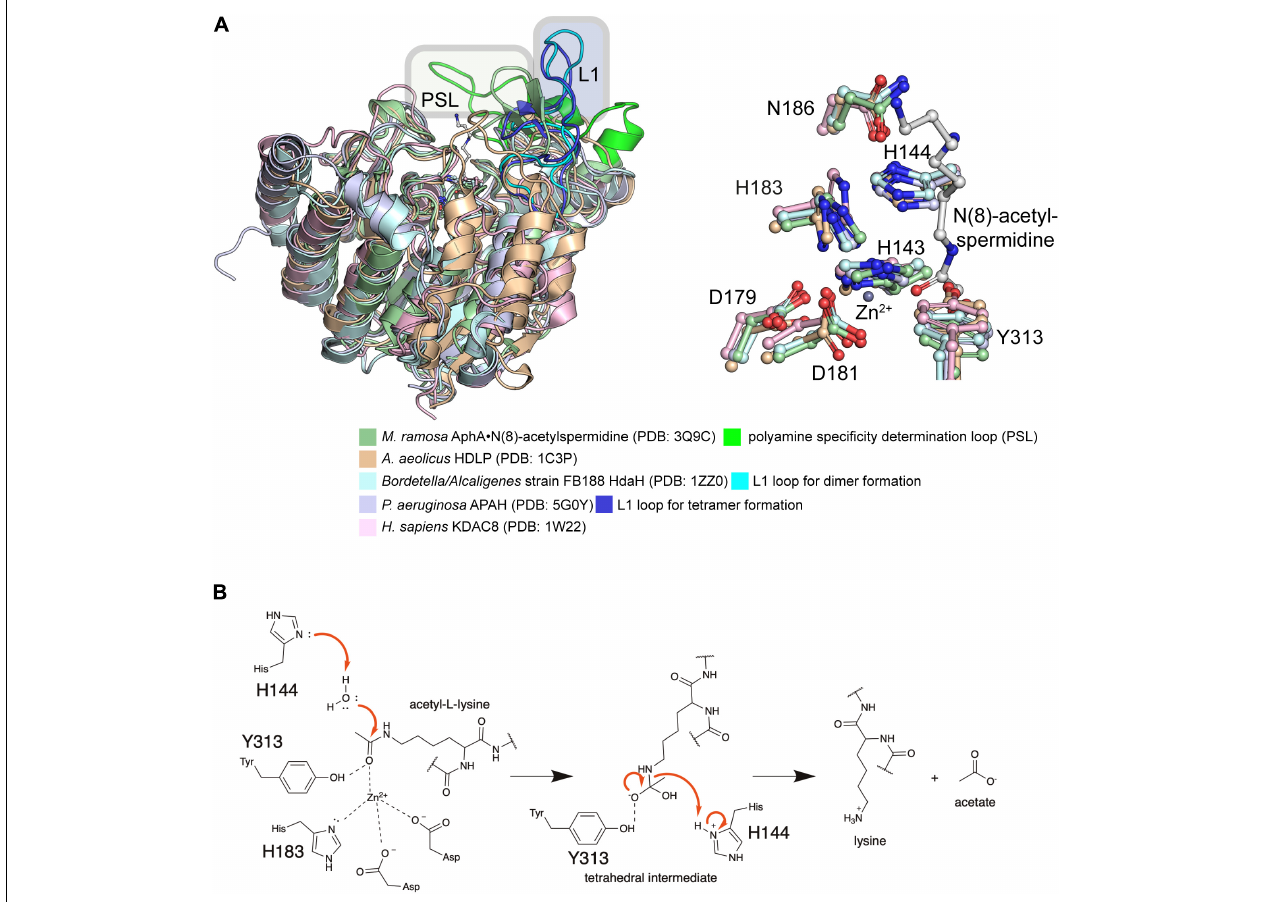
FIGURE 6 | Bacterial Zn 2 + -dependent classical deacetylases. (A) Structural analyses of bacterial classical deacetylases. Left panel: several bacterial classical deacetylases were structurally characterized. The enzyme AphA from M. ramosa encodes for a acetyl-polyamine amidohydrolase (AphA) that was categorized into class II. A. aeolicus histone deacetylase-like protein (HDLP) was classified to class I and Bordetella / Alcaligenes strain FB188 histone deacetylase-like amidohydrolase (HdaH) to class IIb. Both enzymes are active as protein deacetylases. The class IIb enzyme P. aeruginosa APAH (PA3774) was shown to be inactive